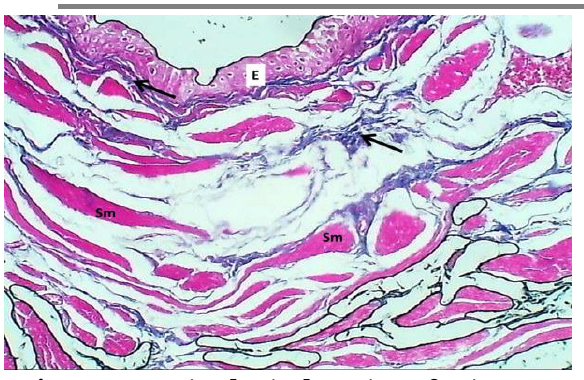
Figure, 11: Histological section of urinary bladder shows: epithelium (E), collagen bundles (arrows) and smooth muscle fibers (Sm), Masson trichrom stain. 100x.